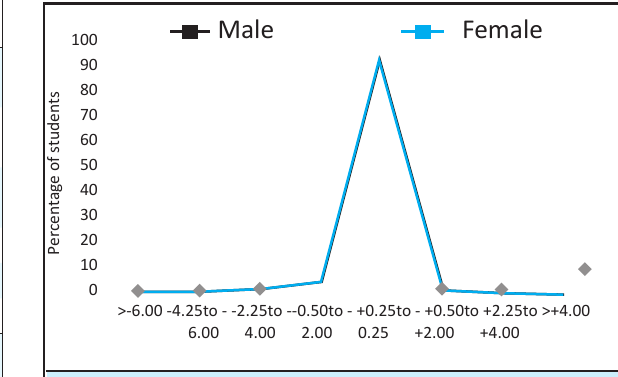
Figure 1. Distribution of refractive error in male and female